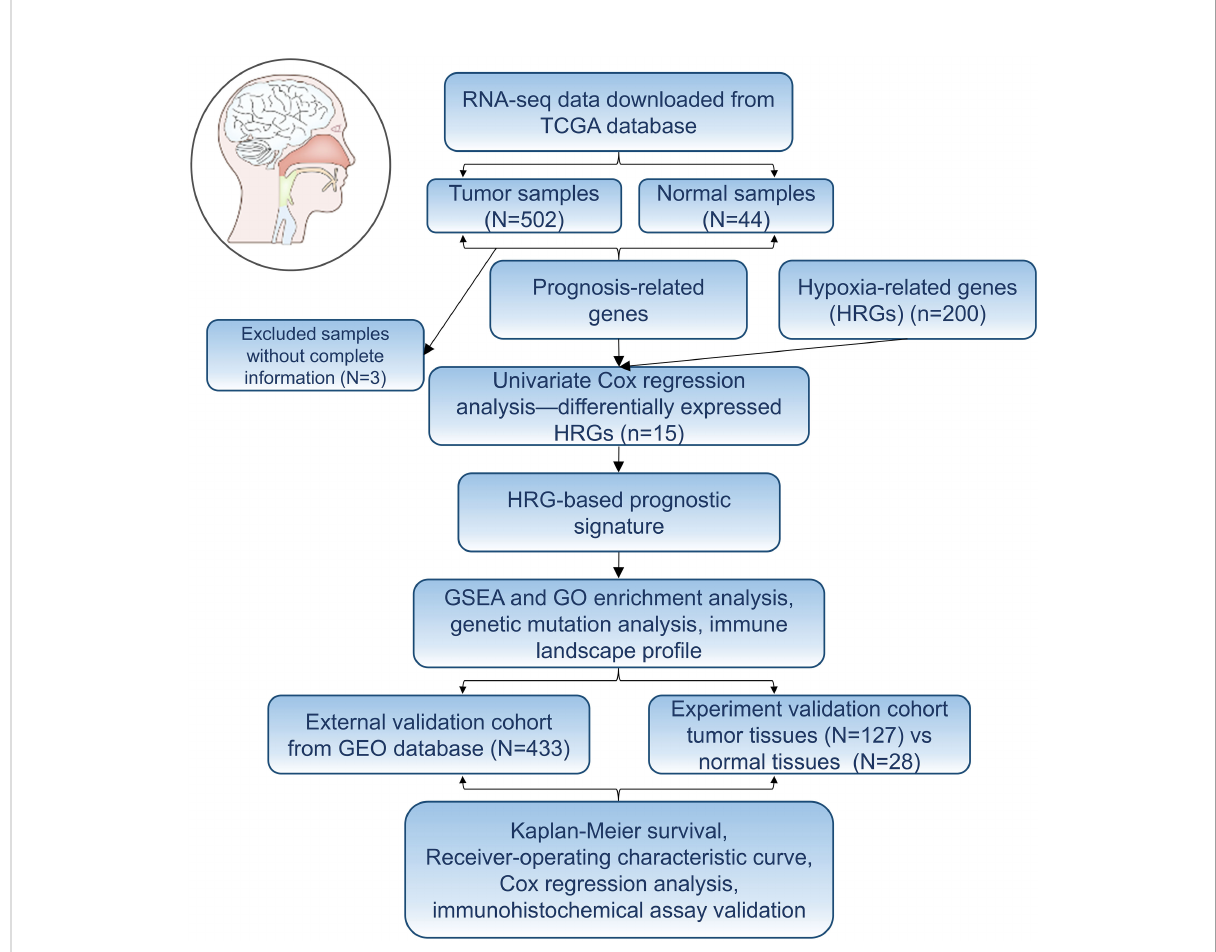
FIGURE 1 Flowchart of establishing a prognostic signature of head and neck squamous cell carcinoma in this